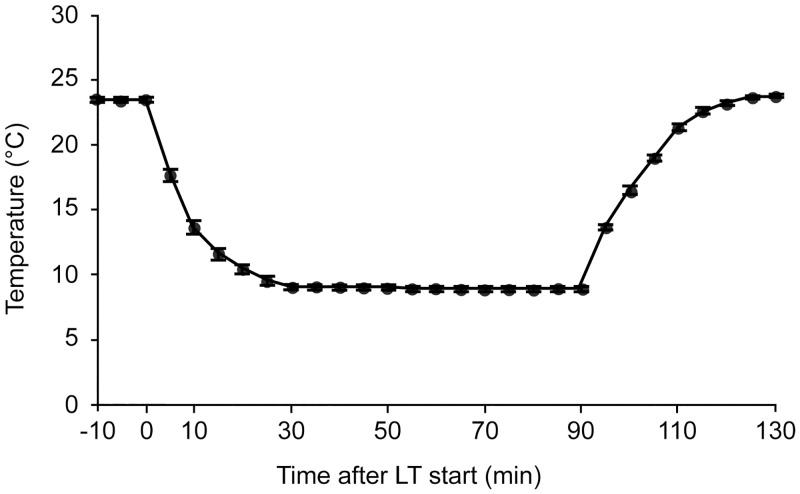
Temperature change of the low ambient temperature (LT) exposure.The average temperature change following LT exposure is shown (mean ± standard error of mean, n = 15). The time after starting LT (min: minutes) is indicated on the horizontal axis.